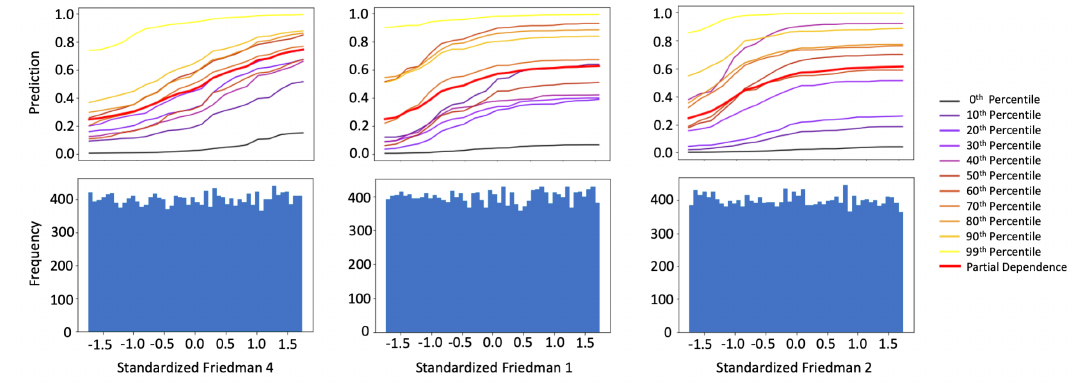
Figure A3. PD, ICE for ten instances across selected percentiles of g MGBM ( X ) , and histograms for the three most important input features of g MGBM on the simulated test